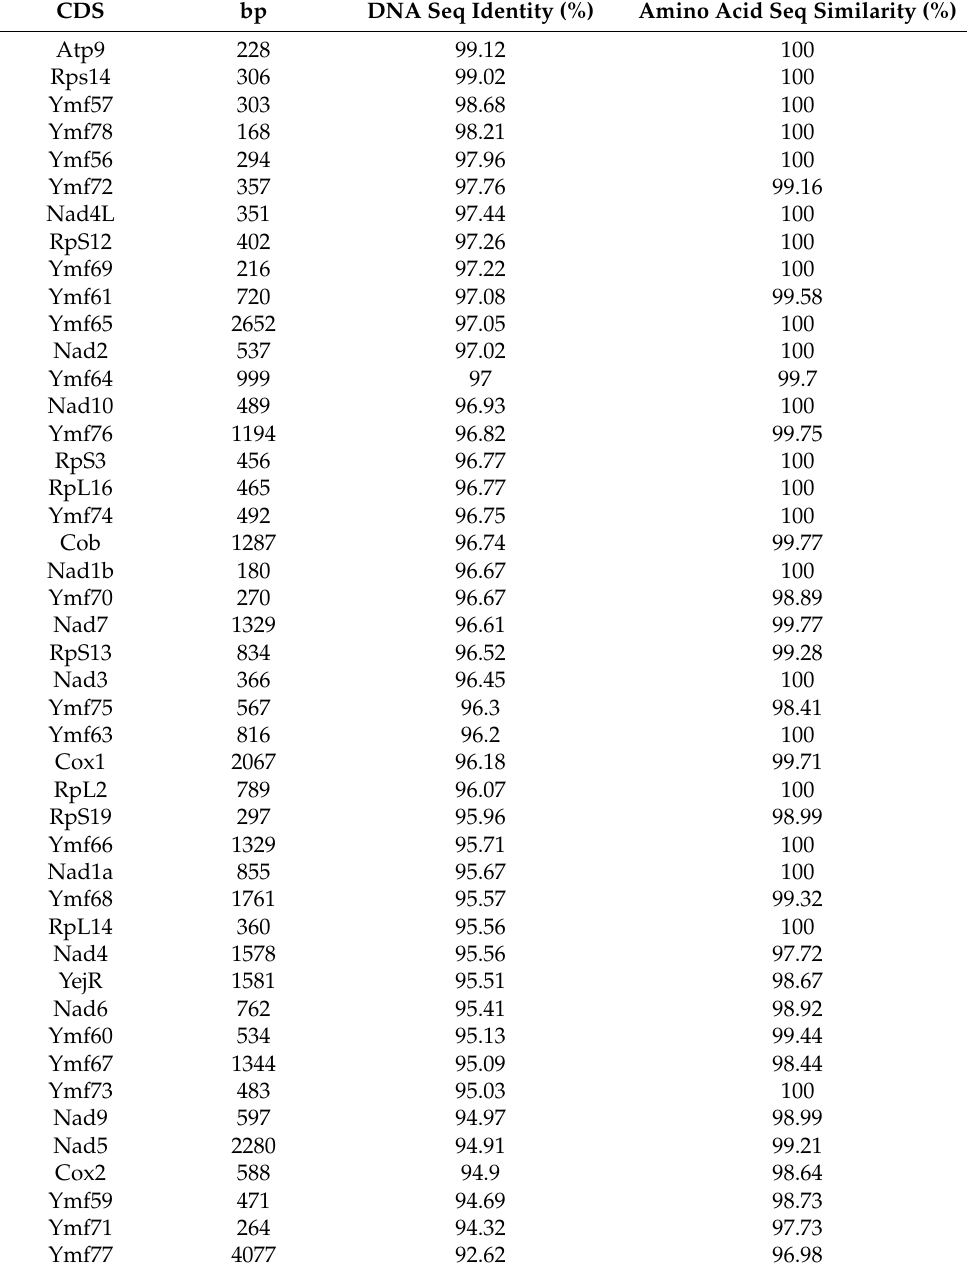
Table 2. Comparisons of protein coding sequences of TRAUS and